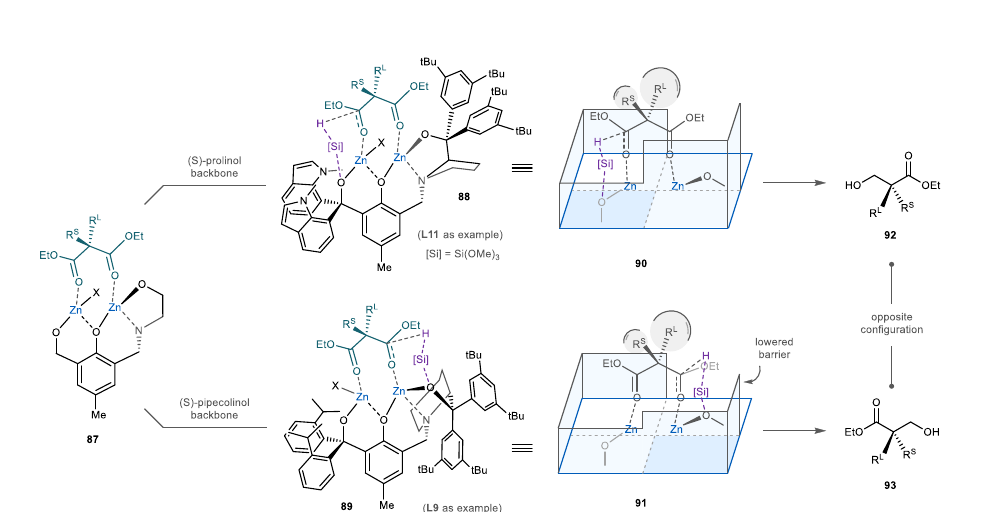
Fig. 6 | Stereochemical consideration and proposal. Our results indicate that ligands derived from prolinols and pipecolinols give hydrosilylation products of opposite con fi guration ( 92 and 93 ). The distinct stereoselectivity is proposed to arisefromthedifferentcatalystpockets.Inthemodelofprolinol-derivedligand( 88 and 90 ), the bulky diaryl motif of the prolinol would repel the large substituent of the malonic ester to the back and block the right front area in 90 . Therefore, the